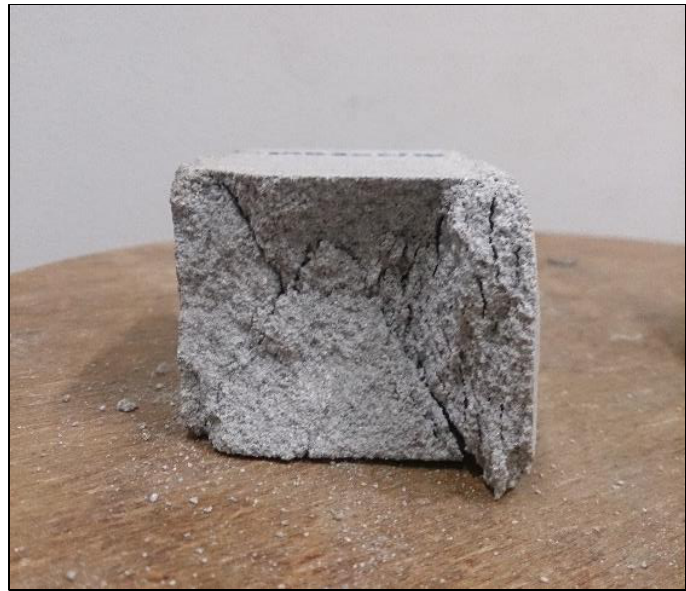
Figure 5. Cross-section of the sample as a result of compression.